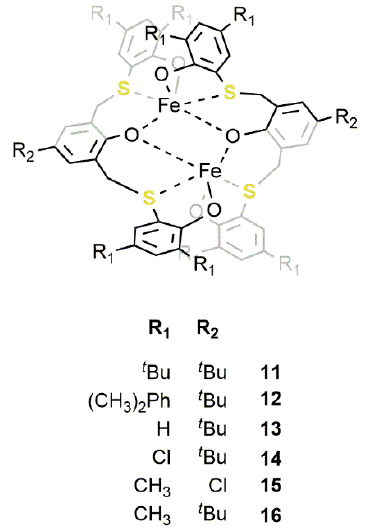
Figure 13. Dinuclear iron(III) complexes 11–16 containing a bis-thioether-triphenolate ligand [67,68].